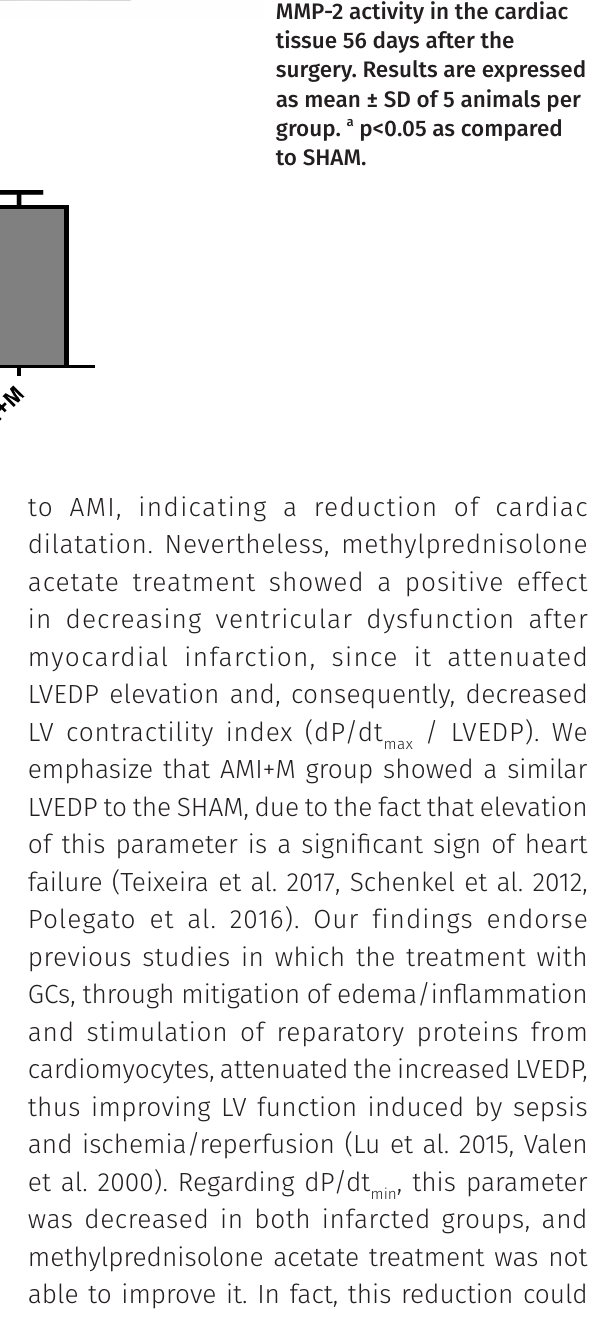
Figure 2. (a) Representative zymographic bands detected in cardiac tissue samples 56 days after surgery from different groups, at 50 to 75 kDa, consistent of that for MMP-2. (b) Quantification of MMP-2 activity in the cardiac tissue 56 days after the surgery. Results are expressed as mean ± SD of 5 animals per group. a p<0.05 as compared to